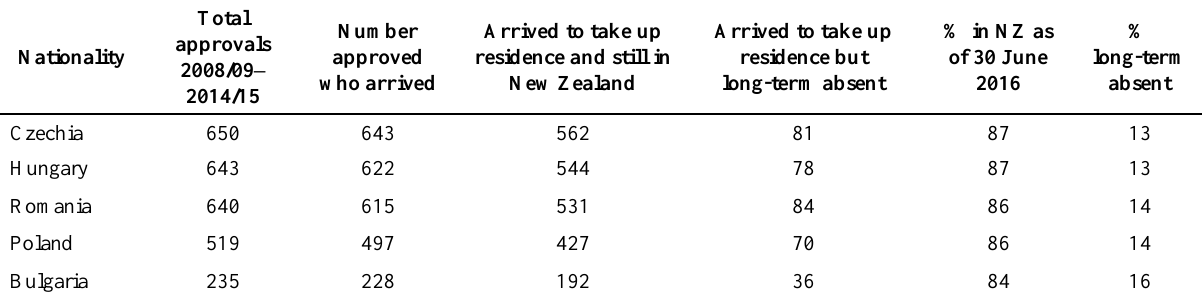
Table 6. Proportion of migrants in New Zealand as of 30 June 2016, top 5 CEE EU-10 countries,